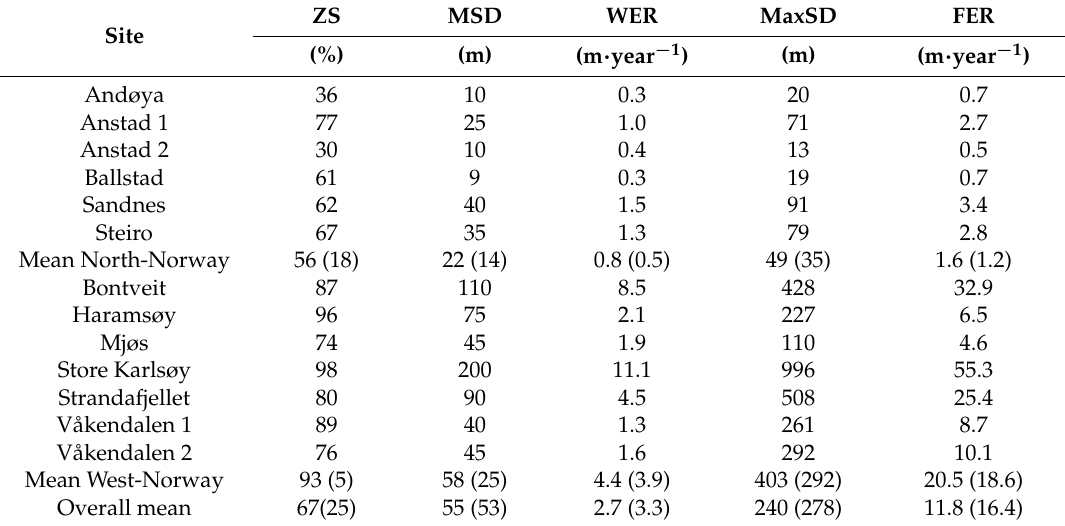
Table 2. Zero-squares (ZS, 10 × 10 m), median spread distance (MSD), and maximum spread distance (MaxSD) for the inventory sites. WER = Wave expansion rate. FER = Frontier expansion rate. Standard deviation in